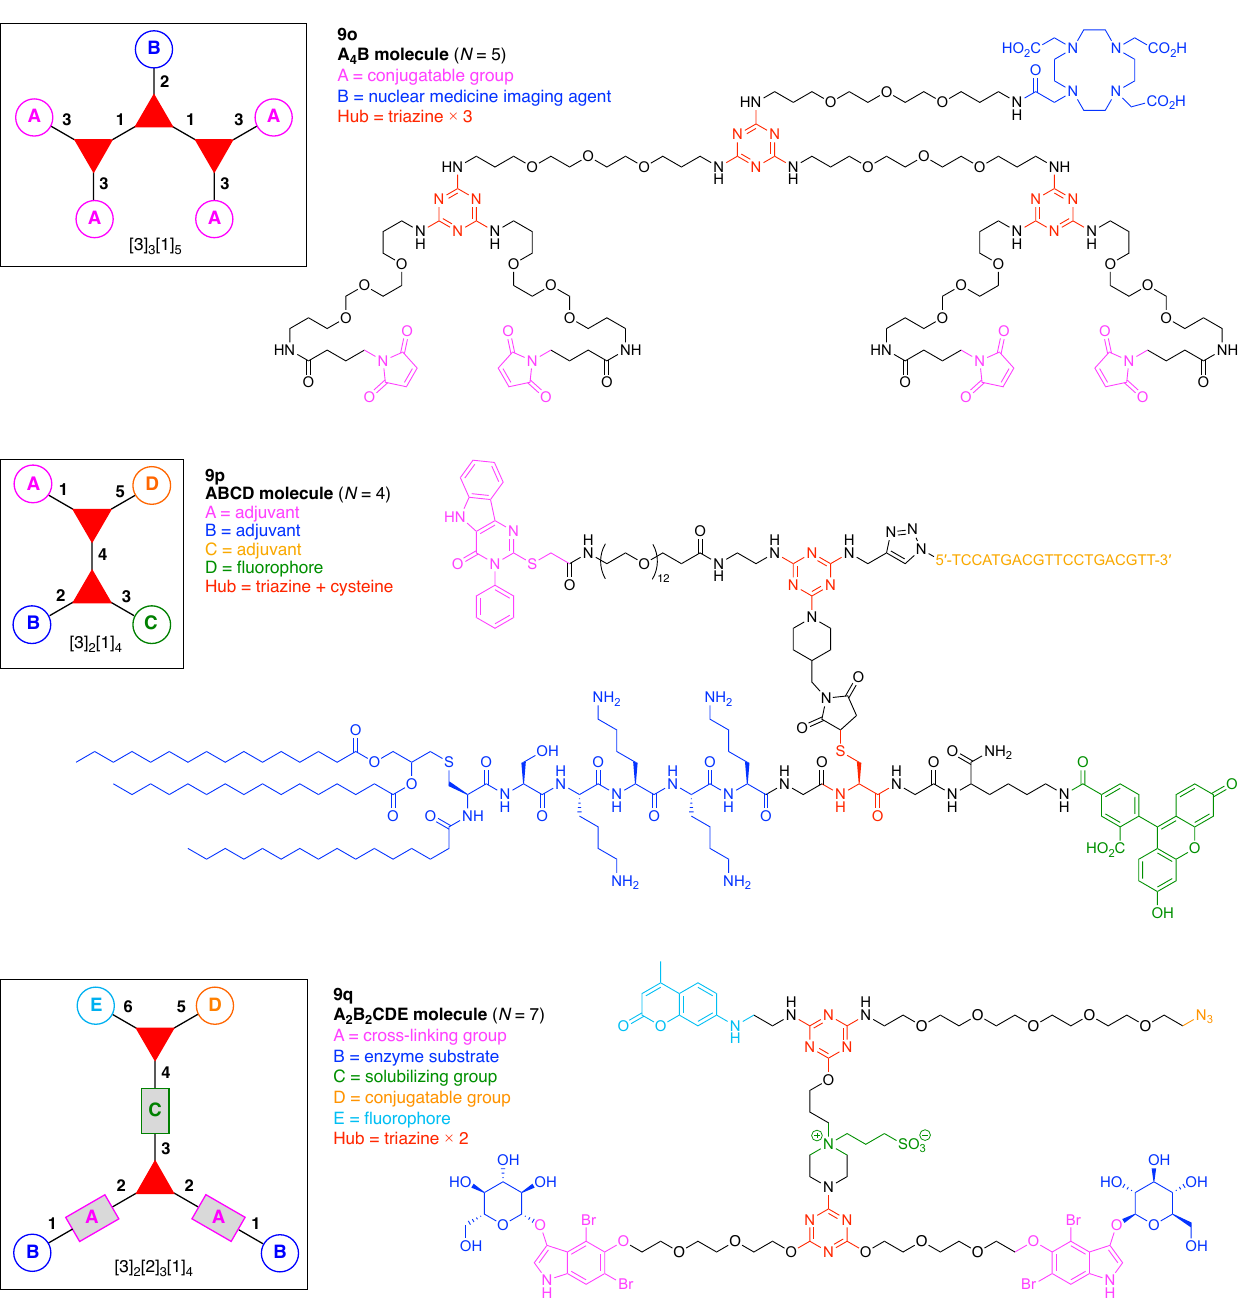
Figure 39. Examples wherein each contains at least one triazine hub.